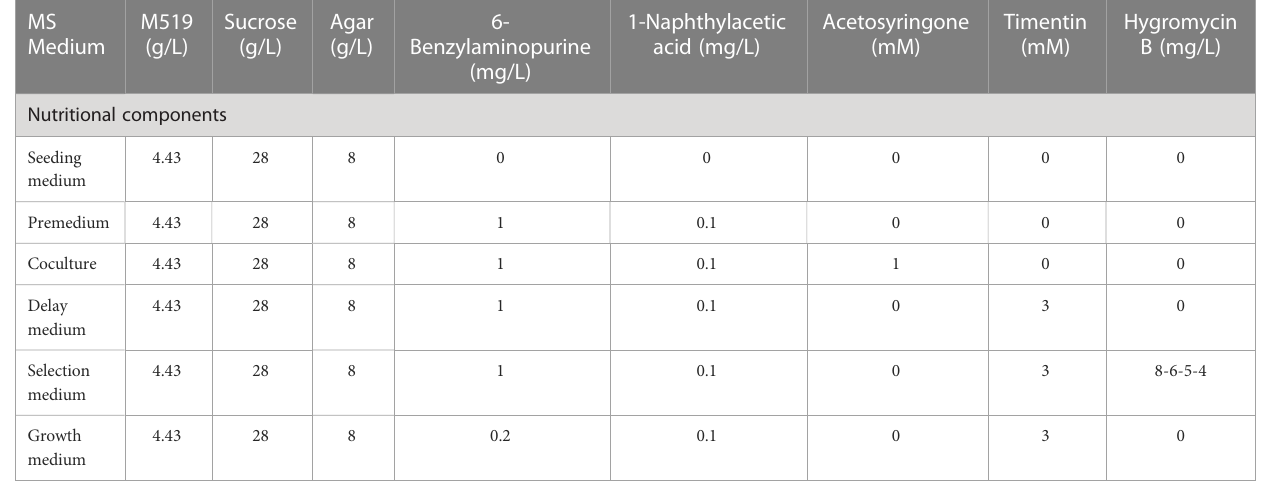
TABLE 1 The medium composition and nutritional components used in this